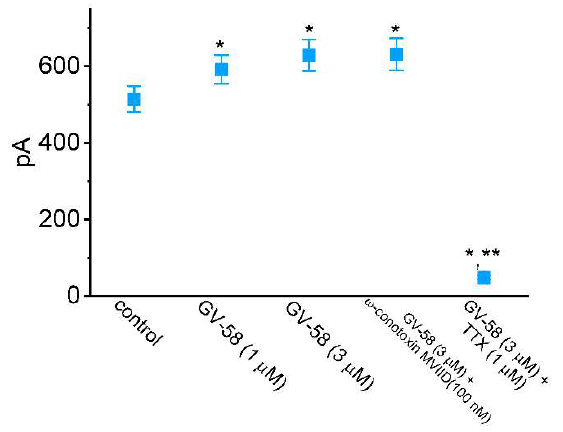
Figure 2. Comparisons of effects of GV-58, GV-58 plus ω-conotoxin MVIID, and GV-58 plus tetro- dotoxin (TTX) on the peak amplitude of I Na recorded from GH 3 cells. Cells were immersed in Ca 2+ - free Tyrode’s solution containing 10 mM TEA, and the pipettes used were filled with Cs + -containing solution. Current amplitude was taken at the beginning of the brief depolarizing pulse from −80 to −10 mV. Each bar indicates the mean ± SEM (n = 8 for each bar). Of notice, the peak I Na in GH 3 cells is subject to inhibition by TTX but not by ω-conotoxin MVIID. * Significantly different from control ( p < 0.05) and ** significantly different from GV-58 (3 μM) alone group ( p < 0.05). Statistical analyses were made by one-way ANOVA among different groups ( p < 0.05).